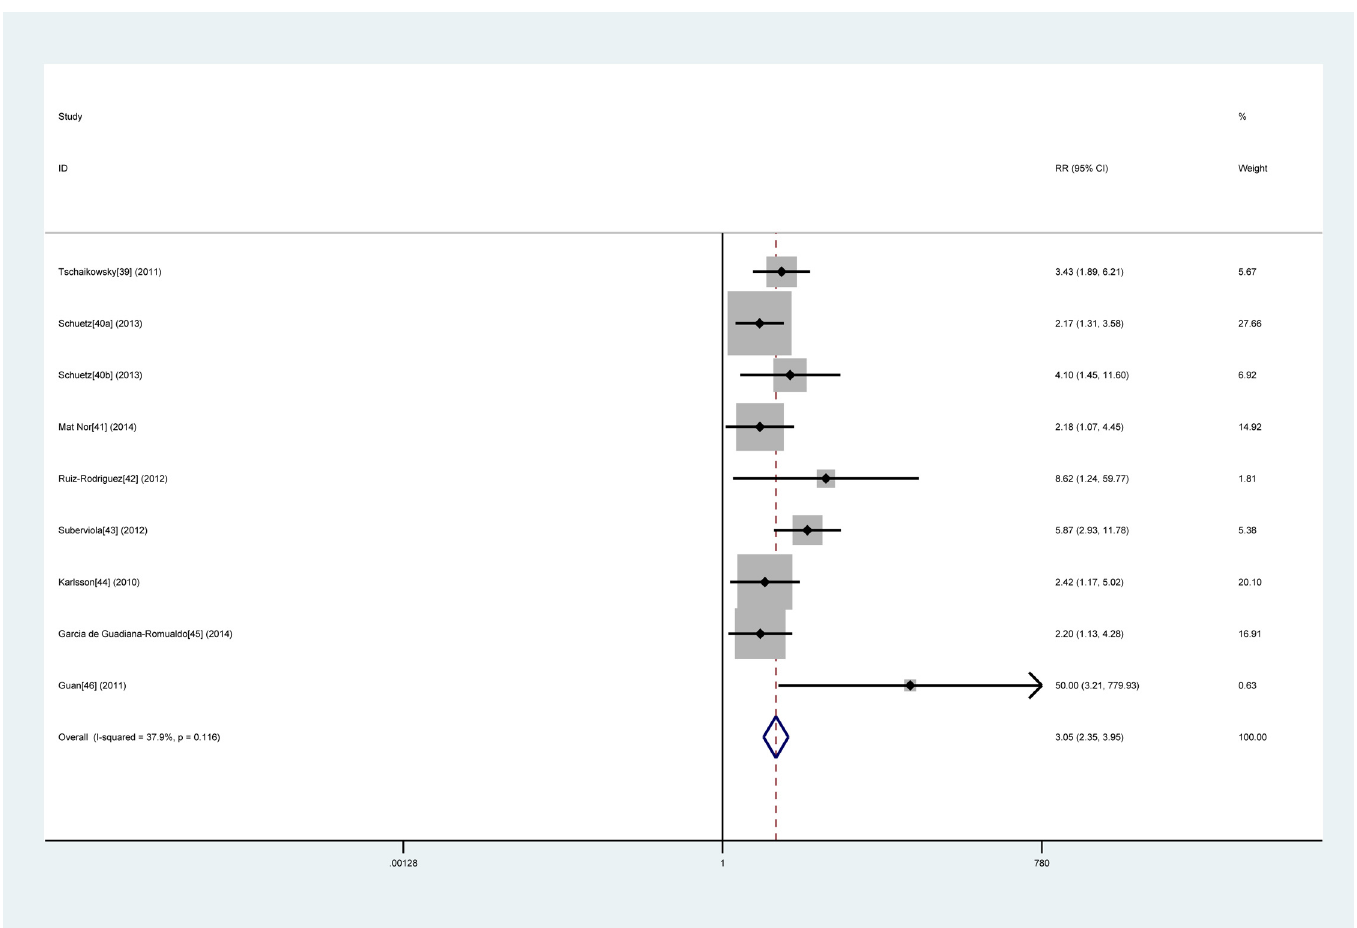
Fig 5. Forest plot of procalcitonin non-clearance to predict mortality in sepsis. The overall pooled RR was 3.05 (95% CI, 2.35 –